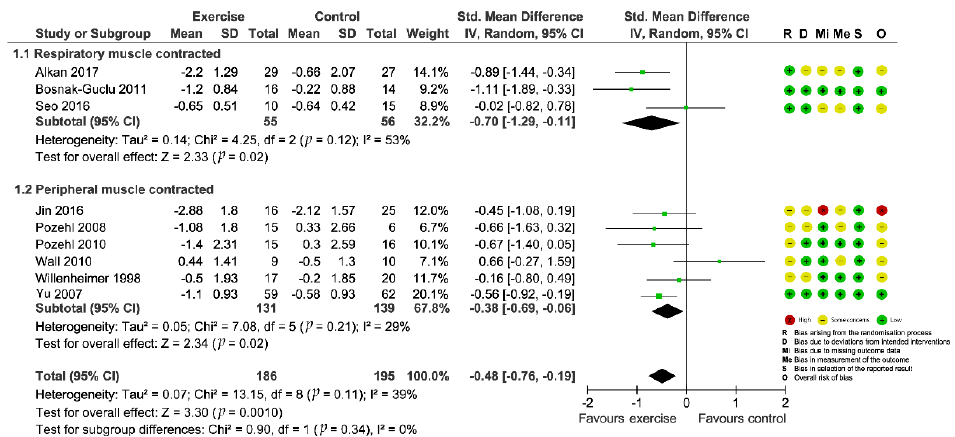
Figure 2. Forest plot showing the effect of exercise-based interventions on dyspnea and risk of bias assessment for each study. (Studies were stratified by the corresponding muscle group contracted during the exercise).